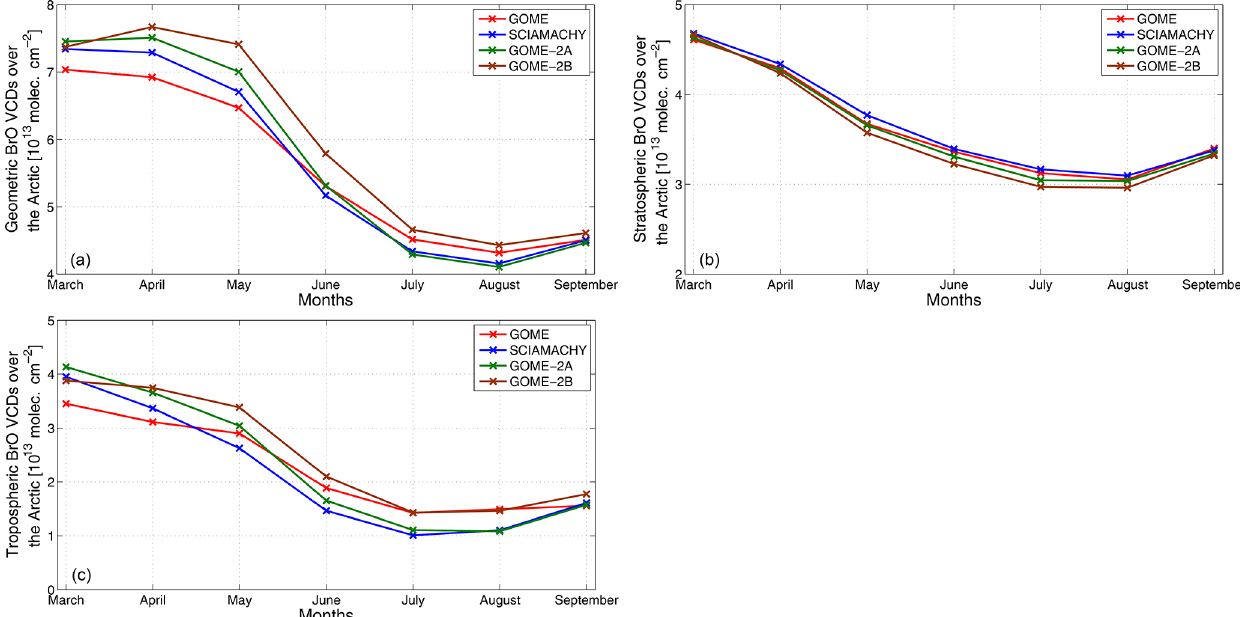
Figure 5. Climatological seasonal cycles of (a) geometric BrO VCDs (10 13 moleccm − 2 ), (b) stratospheric BrO VCDs (10 13 moleccm − 2 ) and (c) tropospheric BrO VCDs (10 13 moleccm − 2 ) over the Arctic for GOME (red), SCIAMACHY (blue), GOME-2A (green) and GOME- 2B